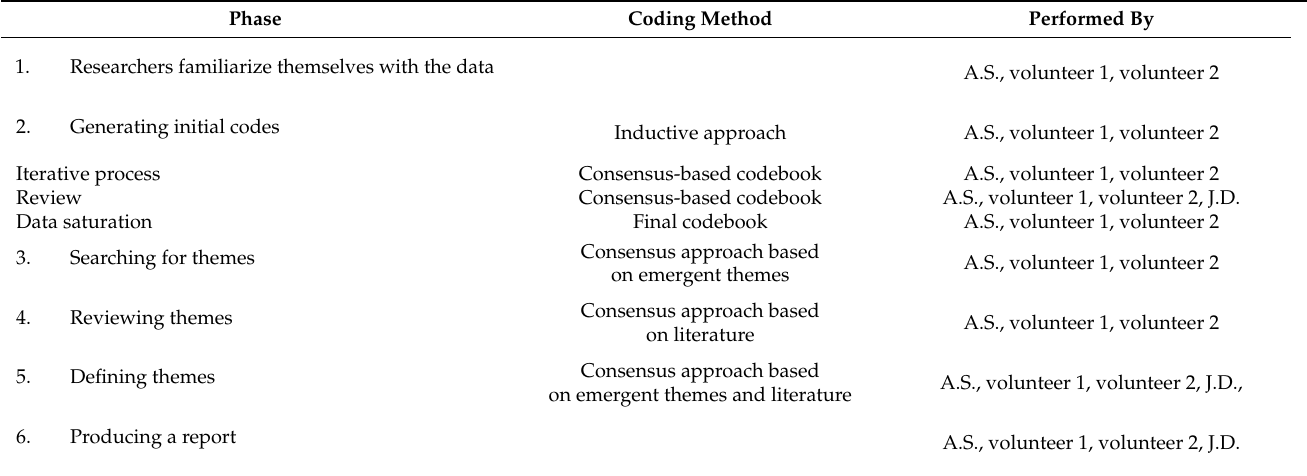
Table 1. Overview of interview transcript analysis.